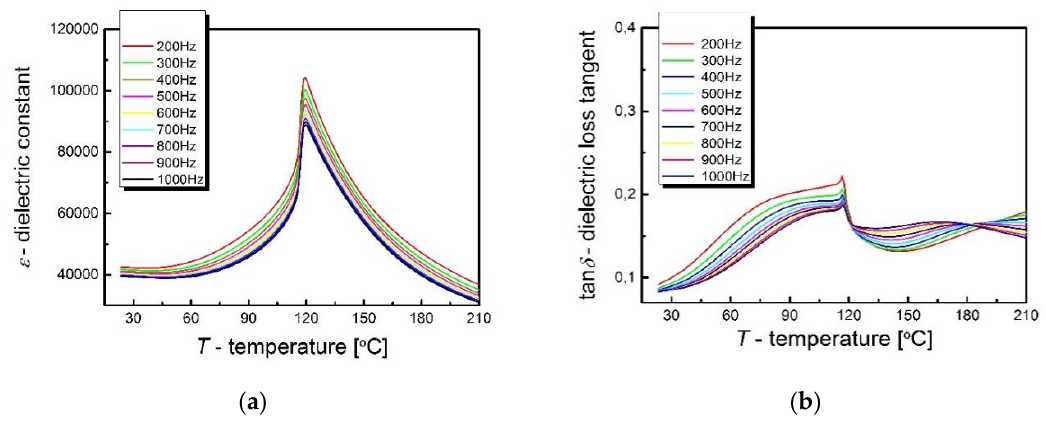
Figure 3. Temperature dependence of electric permittivity ( a ) and tangent of the dielectric loss angle ( b ) on the temperature and frequency of the measuring field for BLT4 ceramics.